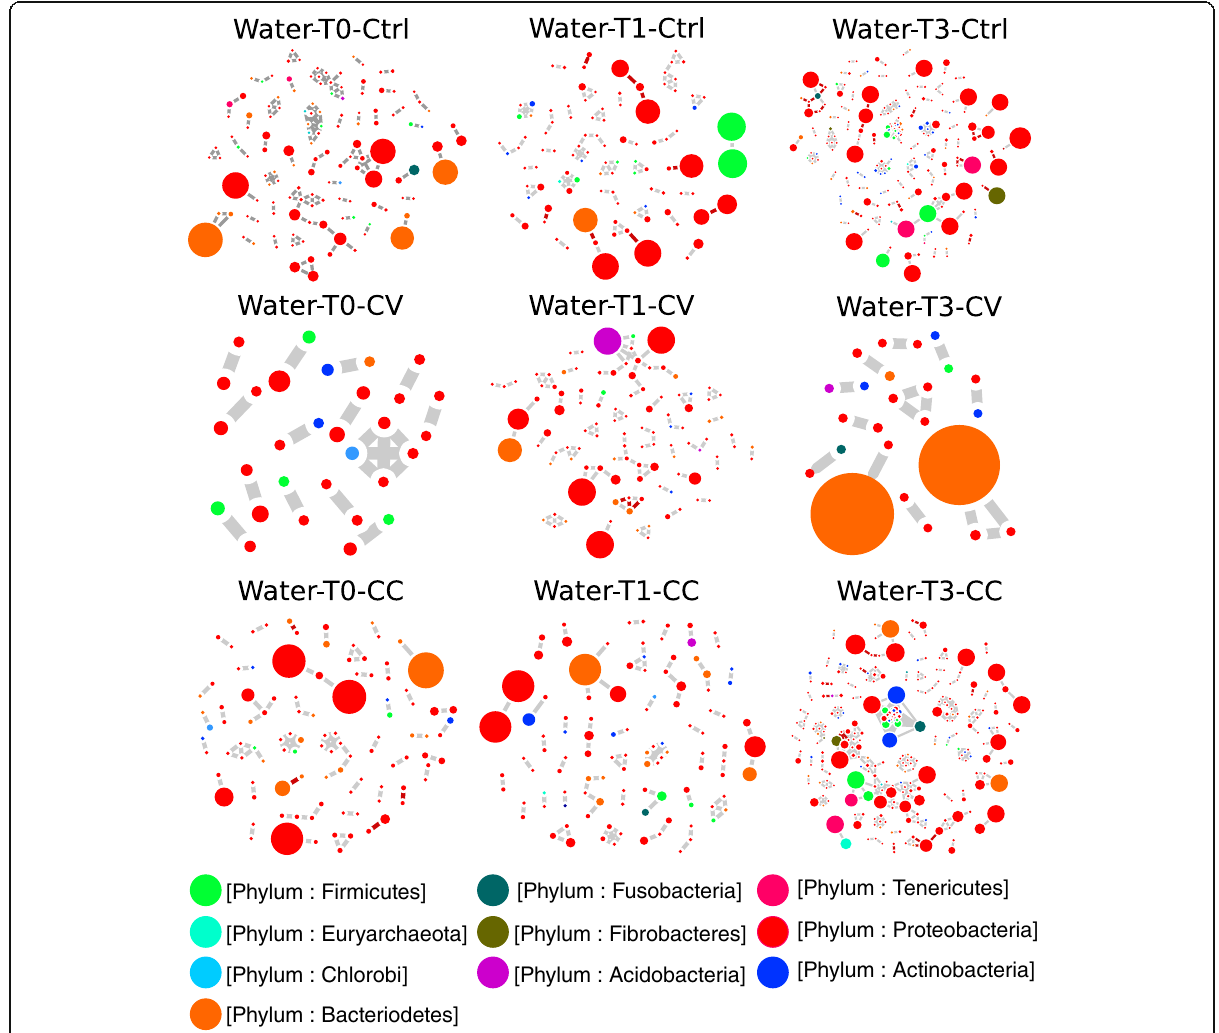
Fig. 4 Correlational co-abundance networks of water microbial community. Water microbial community networks displayed fragmented interactions, over time and between treatments — the topology of water microbial encompassed sub-networks disconnected in small independent hubs. The number of independent hubs was the highest in Control network at T0 and T3, at T3 in CC, and it was always intermediate in CV network (see the Supplementary Table 3). These networks are based on significant Spearman coefficients and were constructed using R scripts and Cytoscape